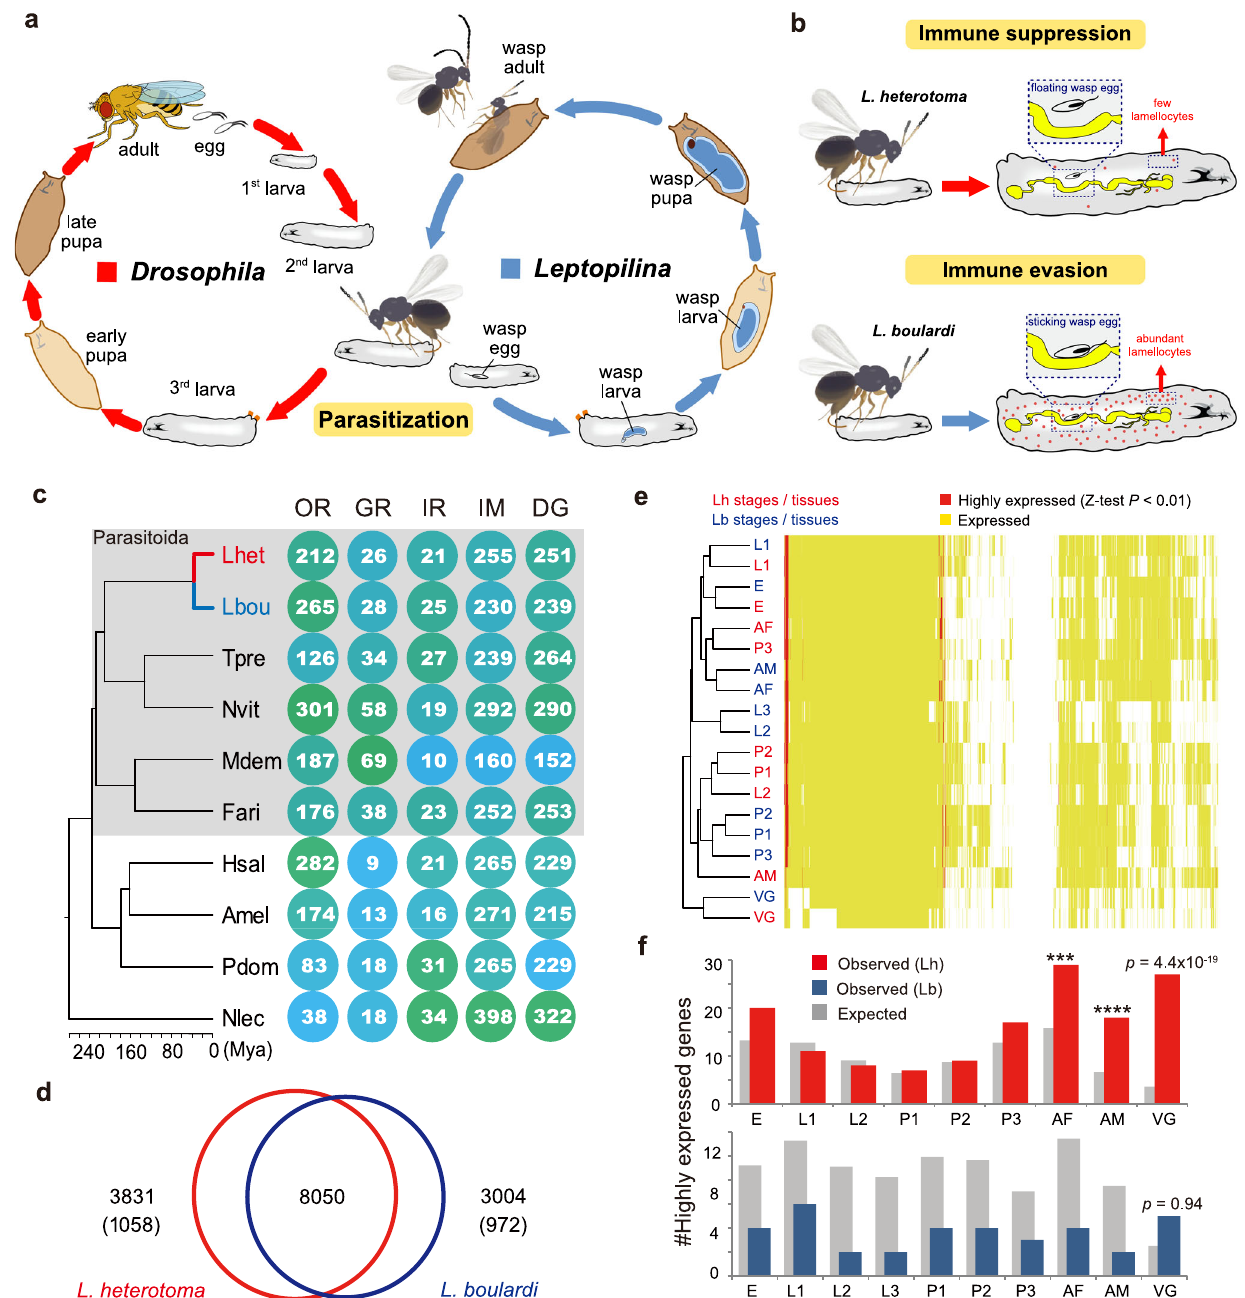
Fig. 1 Comparison between Lh and Lb in ecological and genomic contexts. a The life cycle of Leptopilina (parasitoid) and Drosophila (host). Both L. heterotoma (Lh) and L. boulardi (Lb) are known as larval – pupal parasitoids that deposit their eggs into second instar Drosophila larvae; the growing adults emerge from the host pupa shell approximately 3 weeks later. b Different strategies by which Lh and Lb avoid host immune responses. c Phylogenetic relationships and estimated divergence times among hymenopteran species based on 2401 single-copy orthologous genes. The calibration time was based on a previous study 17 . Right: gene family evolution of representative systems with important roles in parasitoid biology. Circles with a green background indicate gene family expansion, while those with a blue background indicate contraction. OR olfactory receptors, GR gustatory receptors, IR ionotropic receptors, IM immune systems, DG digestive systems, Tpre T. pretiosum , Nvit N. vitripennis , Mdem M. demolitor , Fari F. arisanus , Hsal H. saltator , Amel A. mellifera , Pdom P. dominula , Nlec N. lecontei . d Gene repertoire comparison between Lh and Lb. Numbers in brackets indicate species-speci fi c genes. e Heatmap of expression pro fi les across developmental stages and in venom glands. Each column indicates an orthologous gene pair between Lh and Lb; yellow indicates expression in the corresponding stage (tissue), while red indicates high expression. E eggs, L1 days 1 – 3 larvae, L2 days 4 – 9 larvae for Lh while days 4 – 6 larvae for Lb, L3, days 7 – 9 larvae for Lb, P1 days 1 – 3 pupae, P2 days 4 – 7 pupae, P3 days 8 – 10 pupae, AF female adults, AM male adults, VG venom glands. f Enrichment analysis of highly expressed species-speci fi c genes. Hypergeometric test (higher tail): Bonferroni-adjusted *** P < 0.005 (AF, P = 0.0043; AM, P = 0.0003), **** P < 0.001. Source data are provided as a Source data fi le.